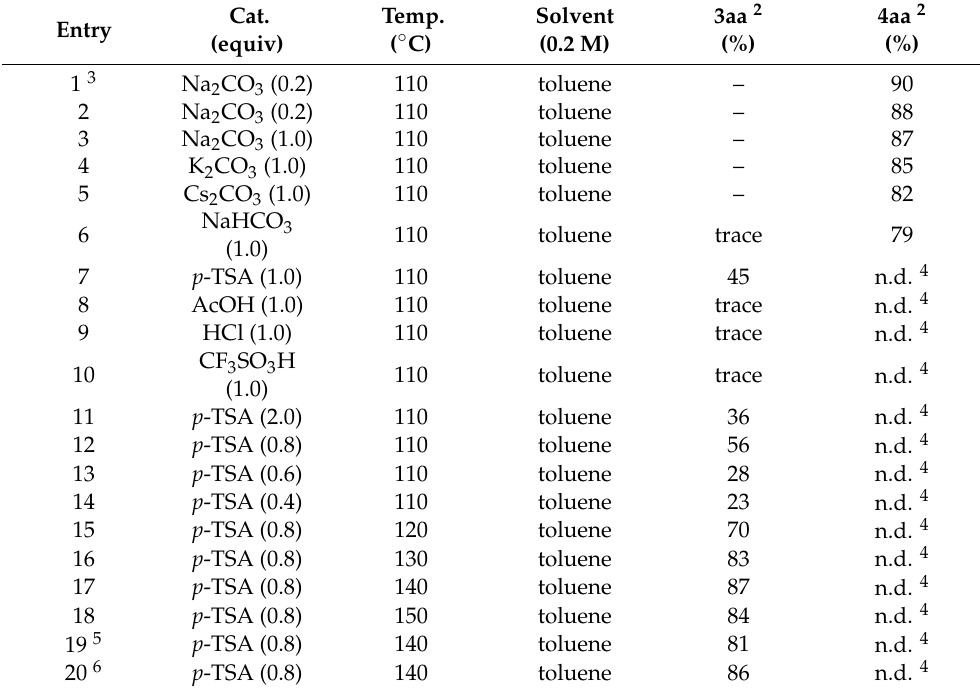
Table 1. Optimization of the cascade cyclization reaction of 1a and 2a 1